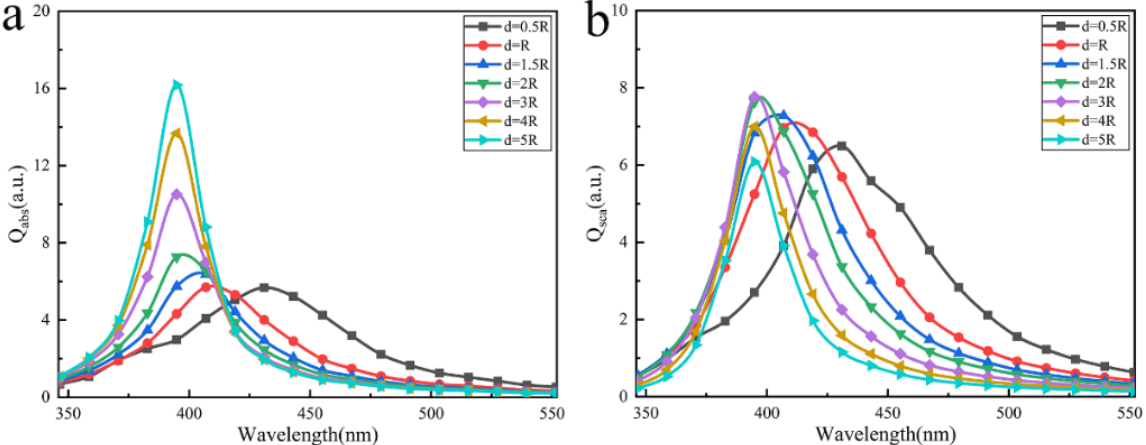
Figure 2. The absorption and scattering efficiencies of the 3 × 3 square array of Ag nanoparticles at different particle spacing with radius R = 14 nm : ( a ) absorption efficiency ( b ) scattering